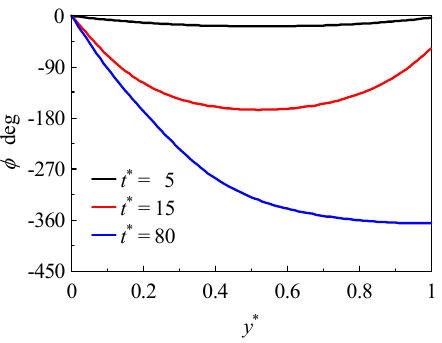
Fig.11 Director angle profiles for Er=100 and Ae=100